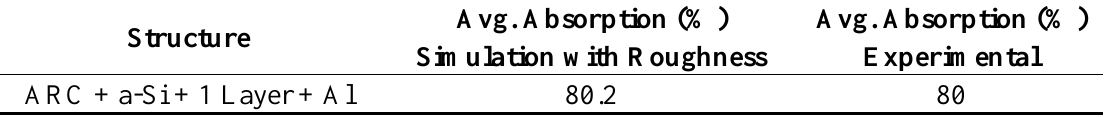
Table 4. Final average absorption values for the structure with an ARC, 1 Layer DBR and aluminum layer. The table compares the experimental results with the simulation that incorporates